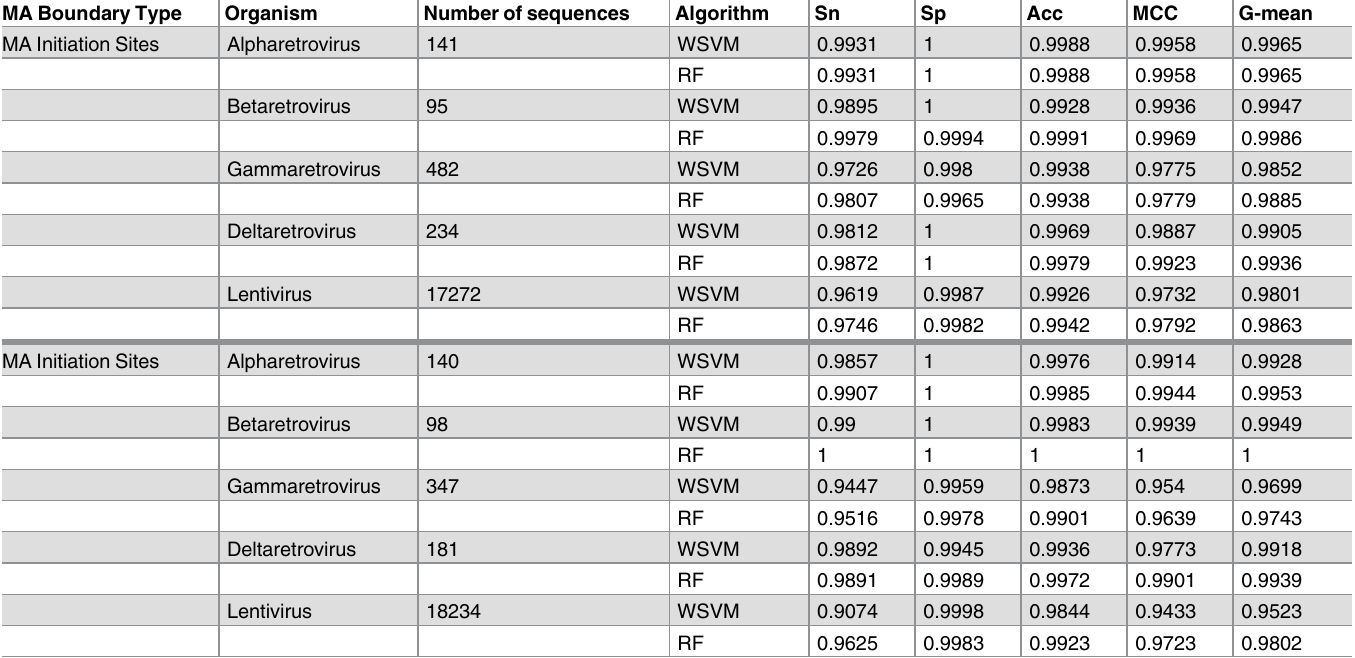
Table 3. Prediction performance of models applied to MA boundaries from different retrovirus